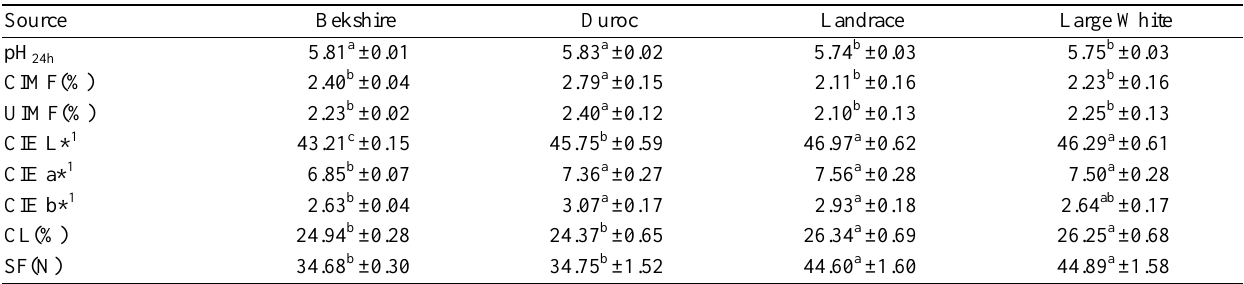
Table 2. Least squares means of the meat quality traits and ultrasound intramuscular fat percentage for breed and their standard errors